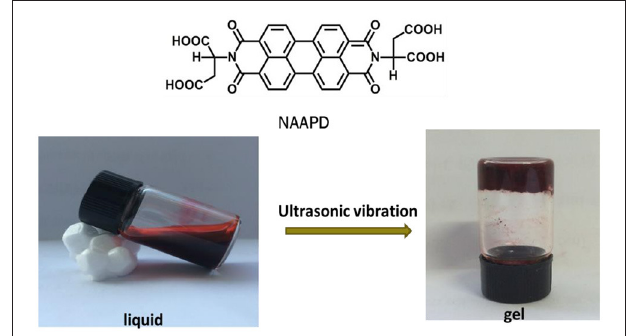
FIGURE 1 | Chemical structures of N , N ′ -diaspartic acid-3,4,9,10-tetracarboxylic diimide (NAAPD), and preparation diagram of supramolecular